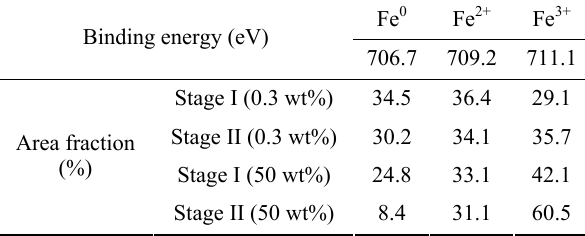
Fig. 8 XPS spectra of Fe 2p on the wear tracks after the friction tests with EPBD-0201 lubrication under different oxygen conditions. Table 3 Parameters of Fe 2p components measured in the worn tracks formed under different experience